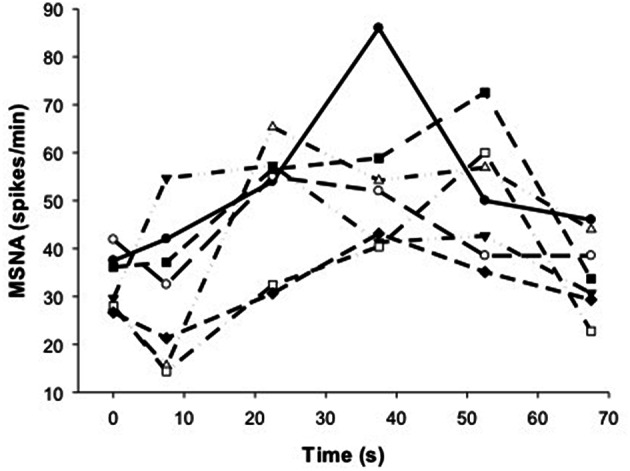
Individual responses of MSNA before (t = 0 s), during (t = 7.5–52.5 s) and after (t = 67.5 s) voluntary contraction.